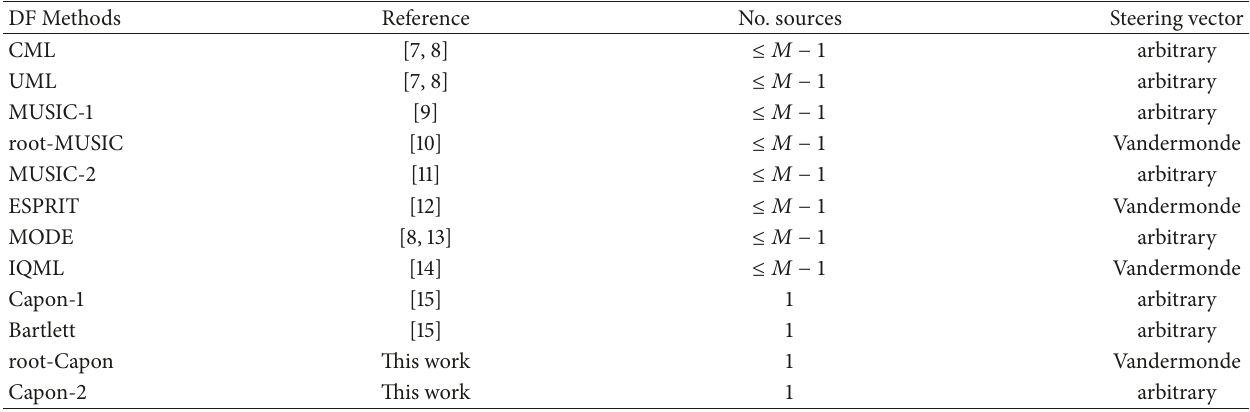
Table 1: Considered narrowband DF techniques, the number of identifiable sources, and the considered structure of the steering